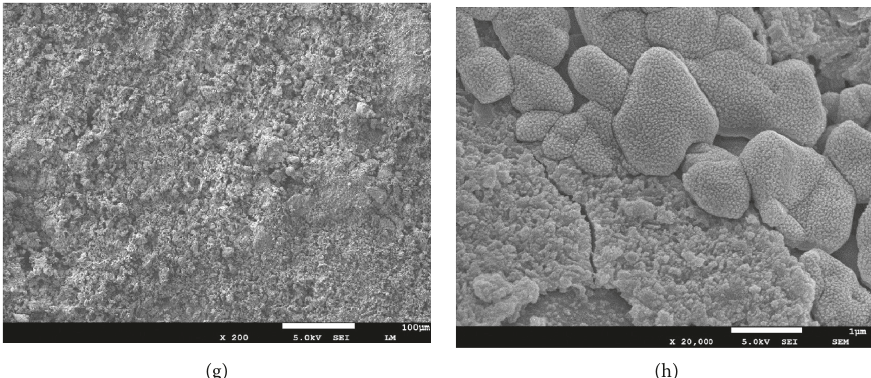
Figure 6: Microstructure of BM samples with the NaOH concentration of 16M: (a, b) F100B0N8; (c, d) F50B50N8; (e, f) F0B100N8; (g, h)